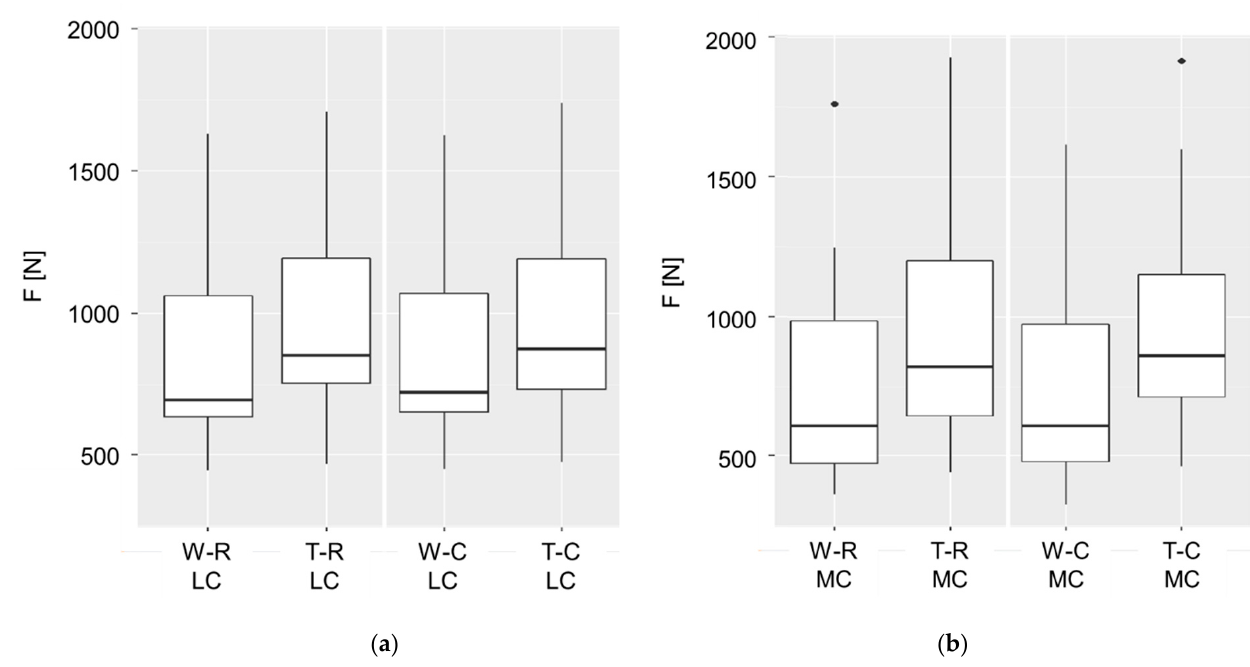
Figure 5. Influence of the interacting factors gait (W = walk, T = trot) and flooring (R = rubber mats, C = concrete) on the force F, shown for ( a ) lateral claws (LC) and ( b ) medial claws (MC); shown are the mean values of subsequences with 3 to 8 consecutive steps from ten dairy cows (modified from Fischer submitted [29]).